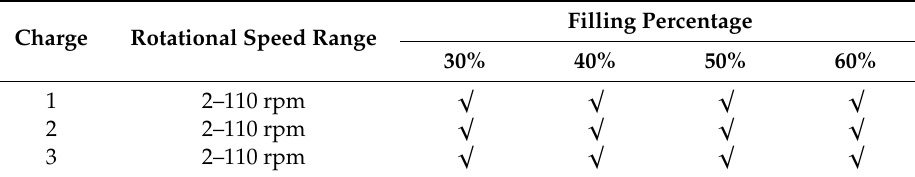
Table 3. Experiments for regime